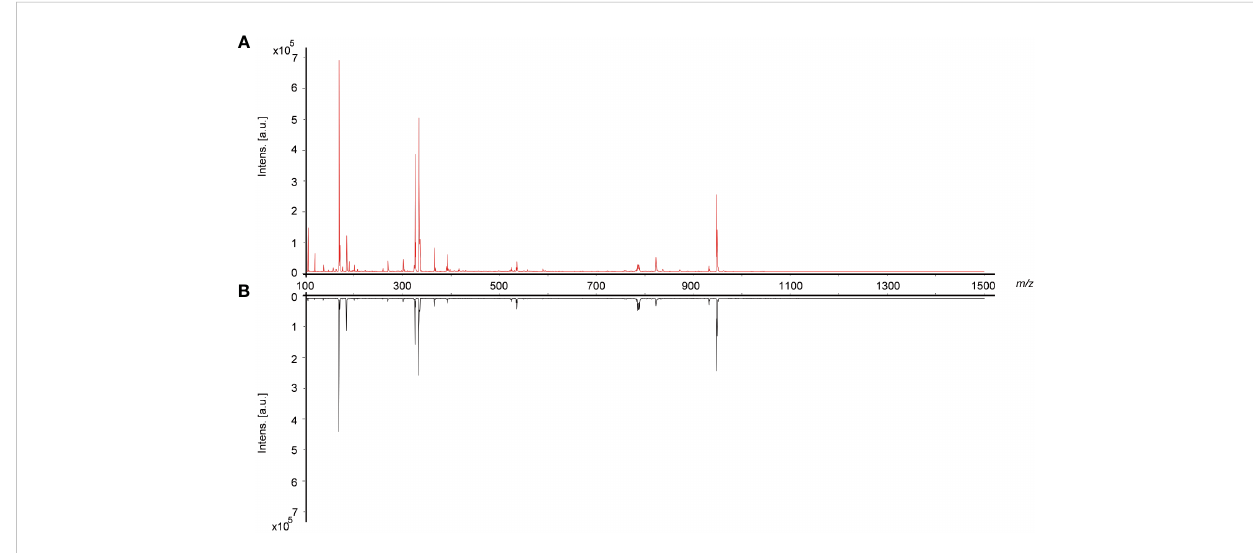
FIGURE 2 Typical overall average mass spectra obtained from cross sections of raw and fried Bombyx batryticatus by MALDI-TOF-MS in a positive mode. (A) Raw Bombyx batryticatus (red). (B) Fried Bombyx batryticatus